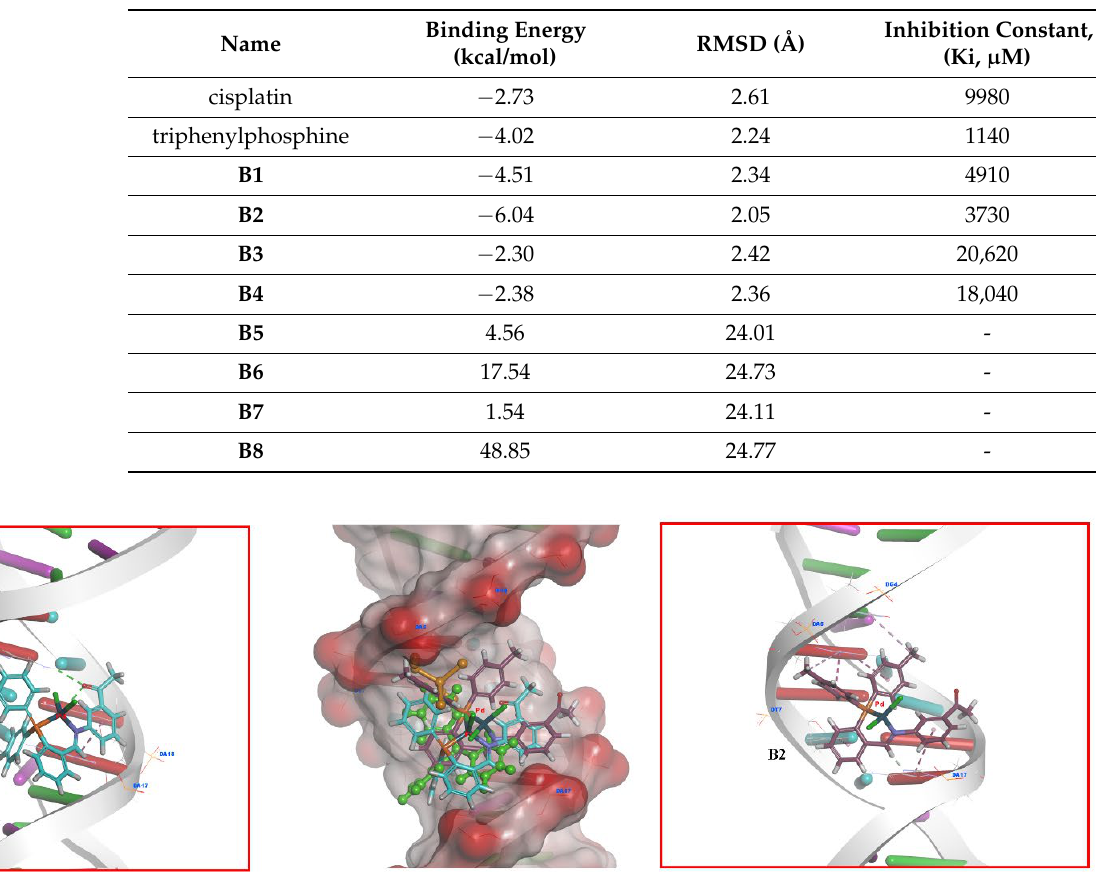
Figure 1. The 3D-binding modes and interactions of B1 (magenta color, stick form) and B2 (cherry color, stick form) with DNA, Superimposed form of the current compounds to cisplatin (orange color, ball, and stick form) and triphenylphosphine (green color, ball, and stick form) as control compounds of DNA.